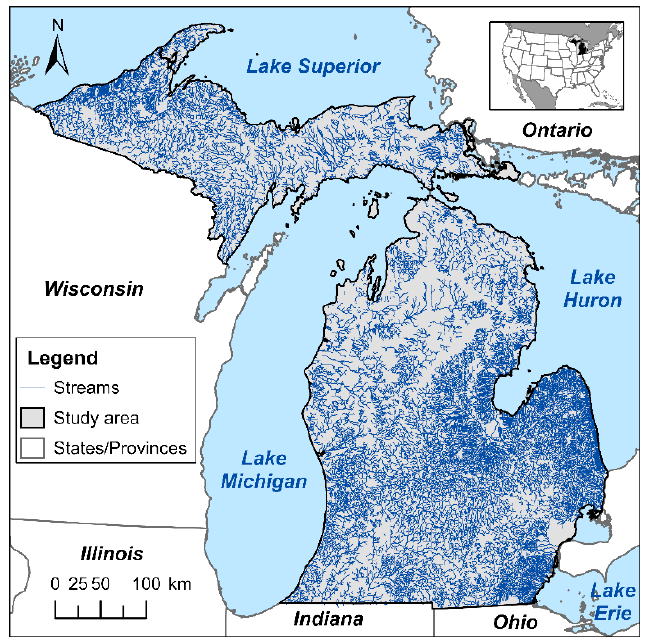
Figure 1. Map of the study